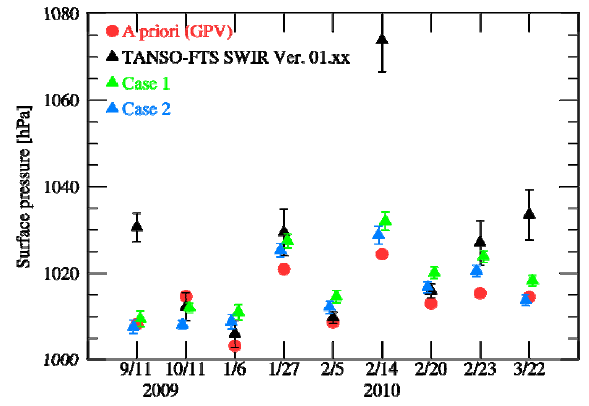
Fig. 7. Comparison of retrieved surface pressure (Case 1 and Fig. 7. Case 2) with a priori pressure. The error bars of the retrieved values are also